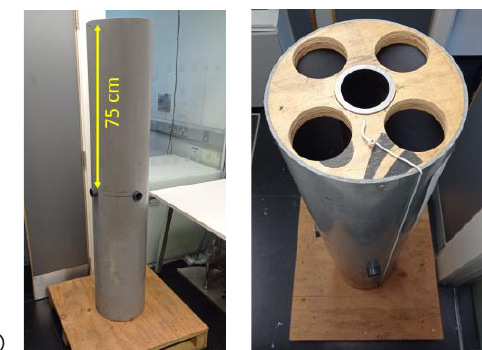
Figure 4 – (a) CAD design of the blind-tube test bed assembled using Solidworks. It includes (1) a carbon steel tube with inner diameter of 75 mm, wall-thickness of 9.5 mm, and cut to a length of 1.5 m, (2) a plastic sand retaining tube with outer diameter of about 320 mm, wall-thickness of 5 mm, and cut to a length of 1.5 m, (3) four plastic ‘void’ tubes placed horizontally at 75 cm from the top, (4) four plastic tubes to hold Ø 25 mm disk point sources, and (5) the base support. (b) Picture of the current configuration.